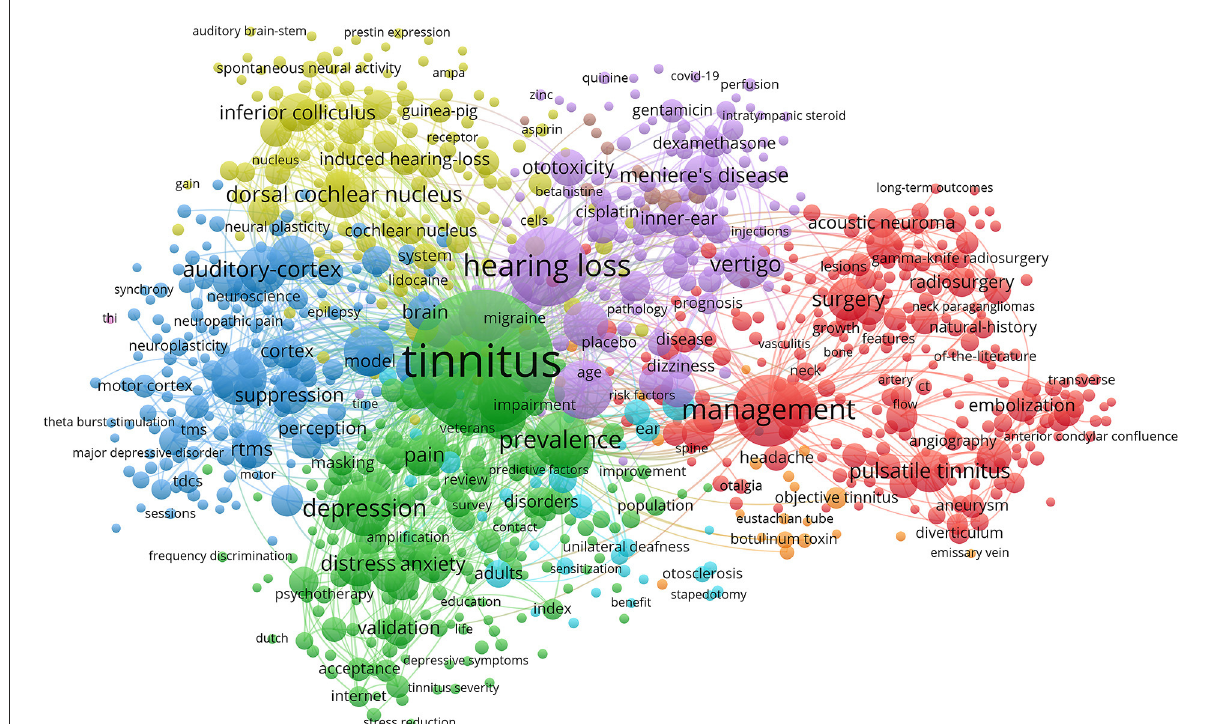
FIGURE7 The font size of each keyword’s name represents the number of articles in the institutions. The thickness of the curved connecting line represents the collaborative intensity between keywords; the keywords collaboration network of research on tinnitus treatment, and the same color represents the same cluster; the brighter the color, the more research about these